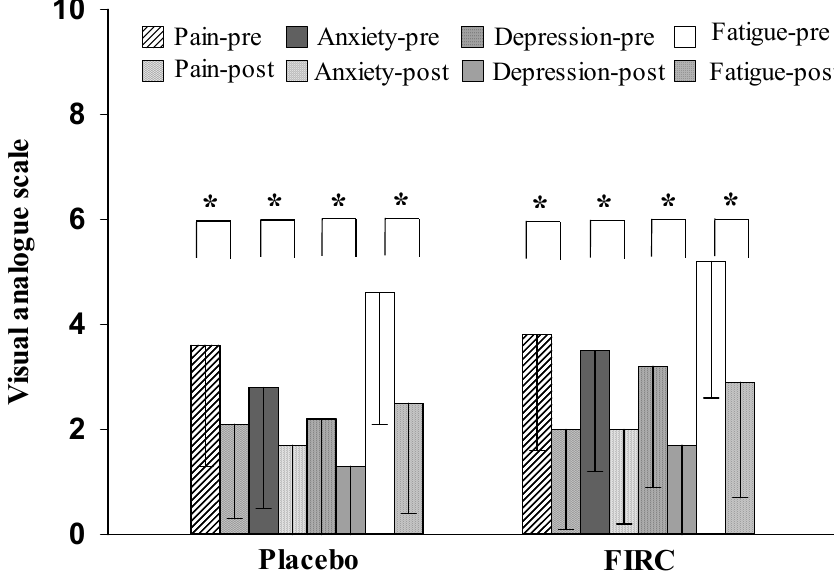
Figure 4. Changes in VAS-Pain, VAS-Anxiety, VAS-Depression, and VAS-Fatigue of placebo and FIRC groups before and after intervention. Asterisk indicates a significant difference.